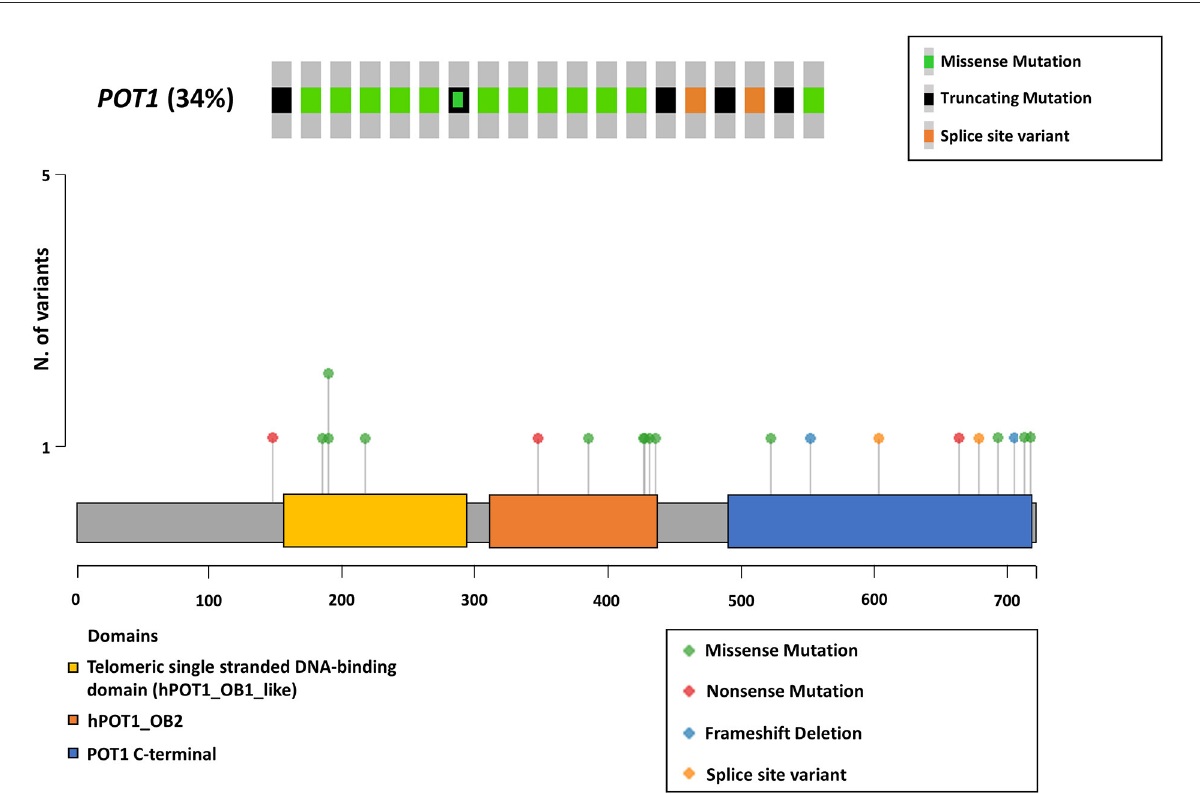
FIGURE1 POT1 somatic mutations. The upper panel shows dogs harboring a protein coding somatic mutation in POT1 gene. Frameshift and non-sense variants are both indicated as truncating mutations. The Oncoprint was generated using the Oncoprinter tool from cBioPortal (https://www. cbioportal.org/oncoprinter). The lower panel shows the lollipop plot of mutations retrieved in the study cohort. The height of each bar represents the frequency at which each mutation occurred. Functional protein domains are also depicted. The lollipop plot was generated using the maftools R package and modified to adapt to canine protein (F1P716_CANLF from UniProt).